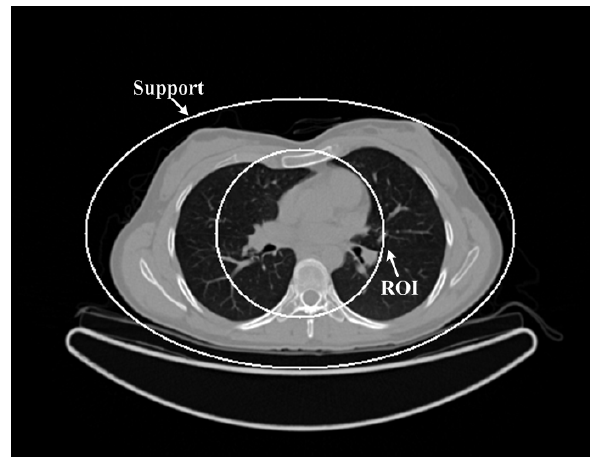
Figure 1. The chest image. The display window is [ − 1000 900]HU.